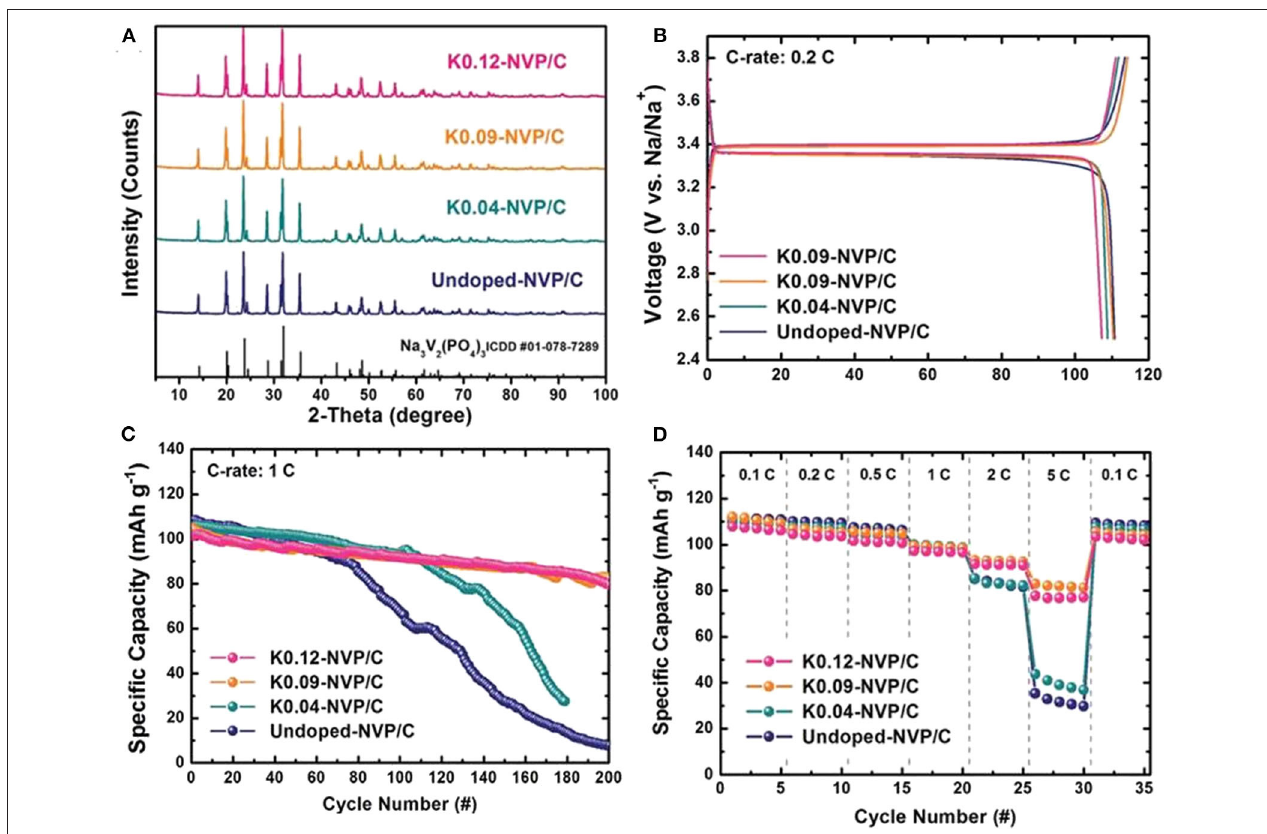
FIGURE 7 | (A) XRD patterns of NVP/C doped with K + , (B) initial charge-discharge curve, (C) cycle property of NVP/C doped with K + , (D) rate capabilities of NVP/C doped with K +